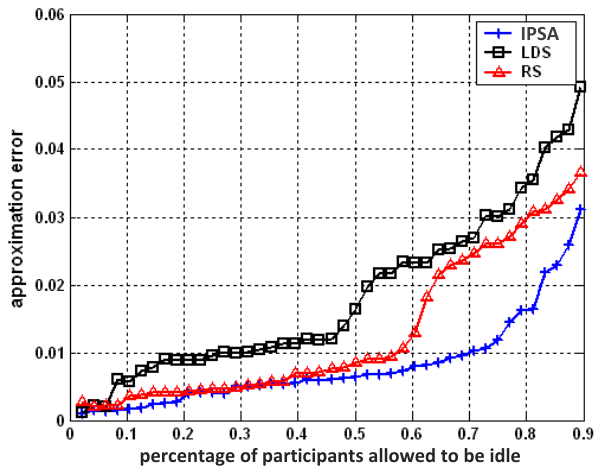
Figure 7. Approximation errors comparison of IPSA vs. RS, LDS.